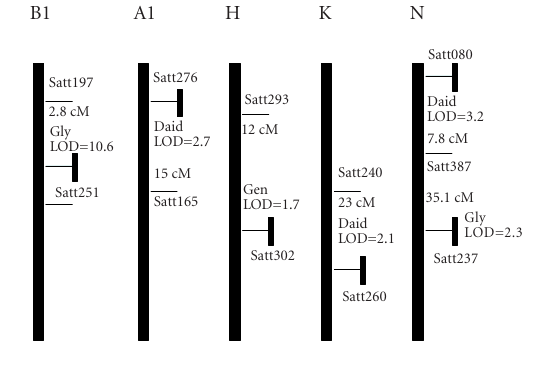
Figure 3: Location of microsatellite markers and QTL that condi- tion phytoestrogen content. END indicates the likely position of the telomereonthatlinkagegroup,thedisjunctbarrepresentstherestof the linkage group. Marker names and distances and peak LOD score for the interval are given. LOD scores are from single locus analyses of additive gene effects using Mapmaker/QTL 1.1. Genetic distances were from the recombinant inbred line function of Mapmaker/EXP